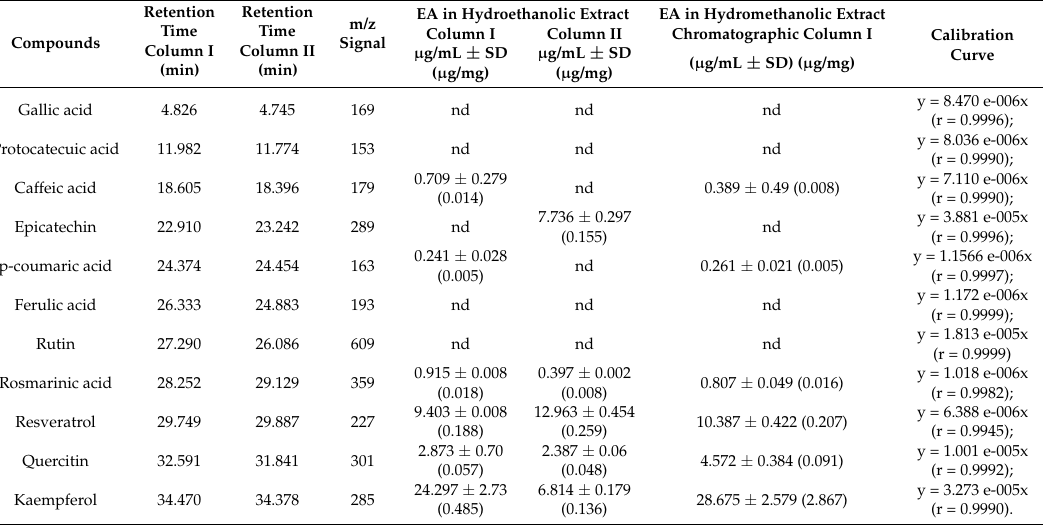
Table 2. The individual polyphenols of the hydroalcoholic extract of the aerial part of Ephedra alata Decne. (EA), and the LC-MS parameters.